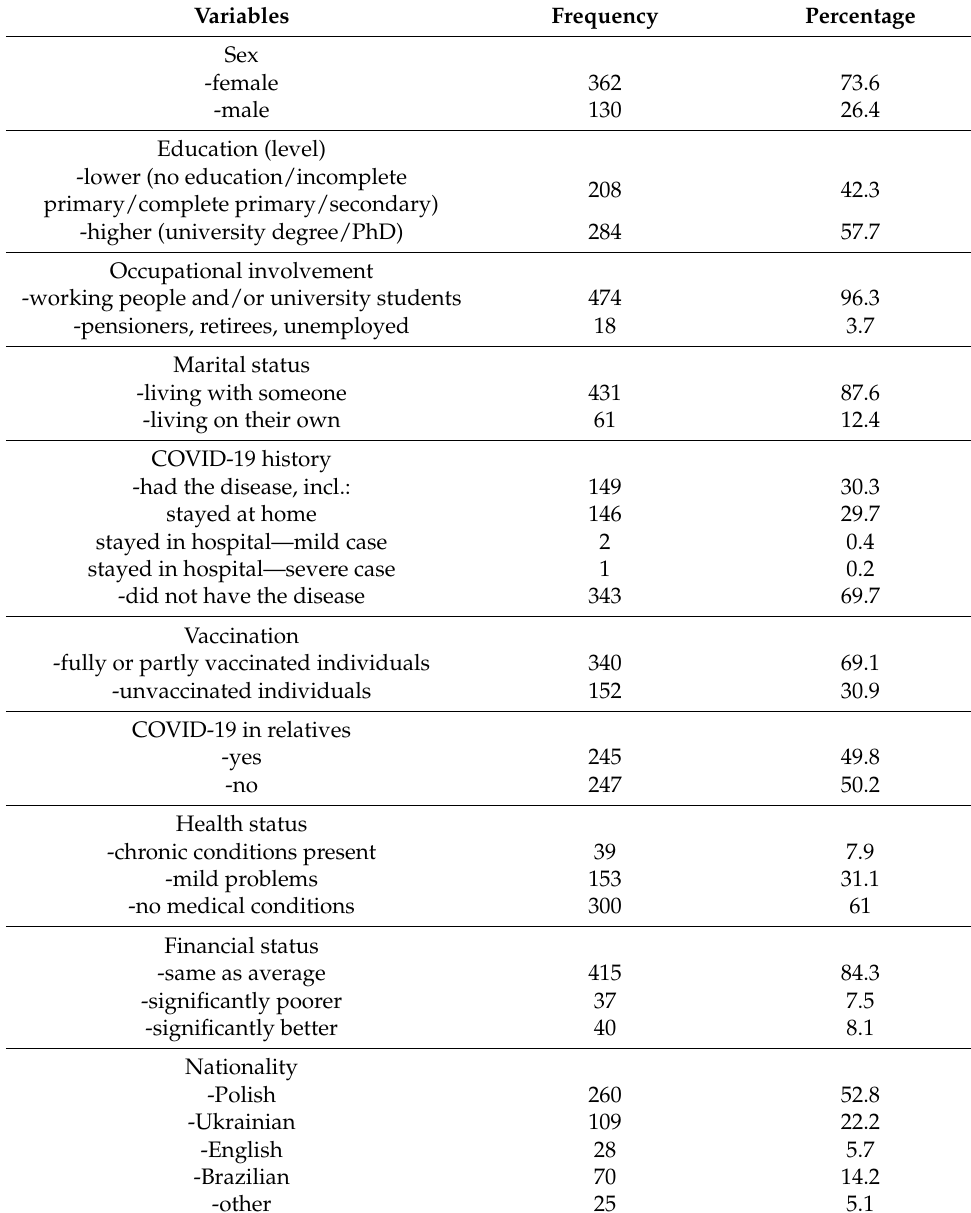
Table 1. Socio-demographic characteristics of the sample ( N = 492).